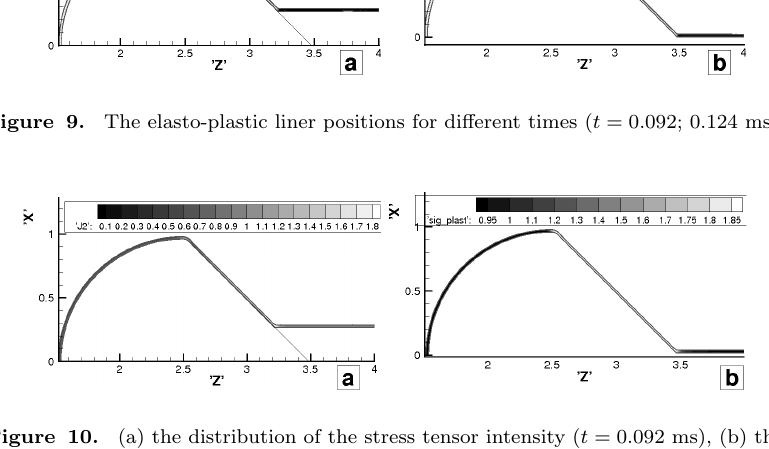
Figure 10. (a) the distribution of the stress tensor intensity ( t = 0 . 092 ms), (b) the distribution of the yield stress ( t = 0 . 124 ms).